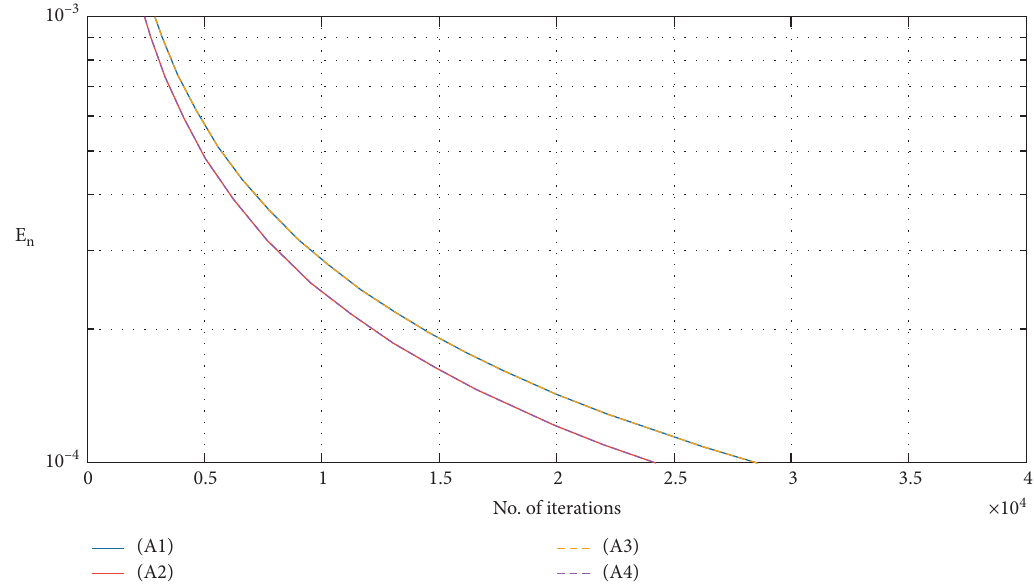
Figure 3: The convergence behavior of E